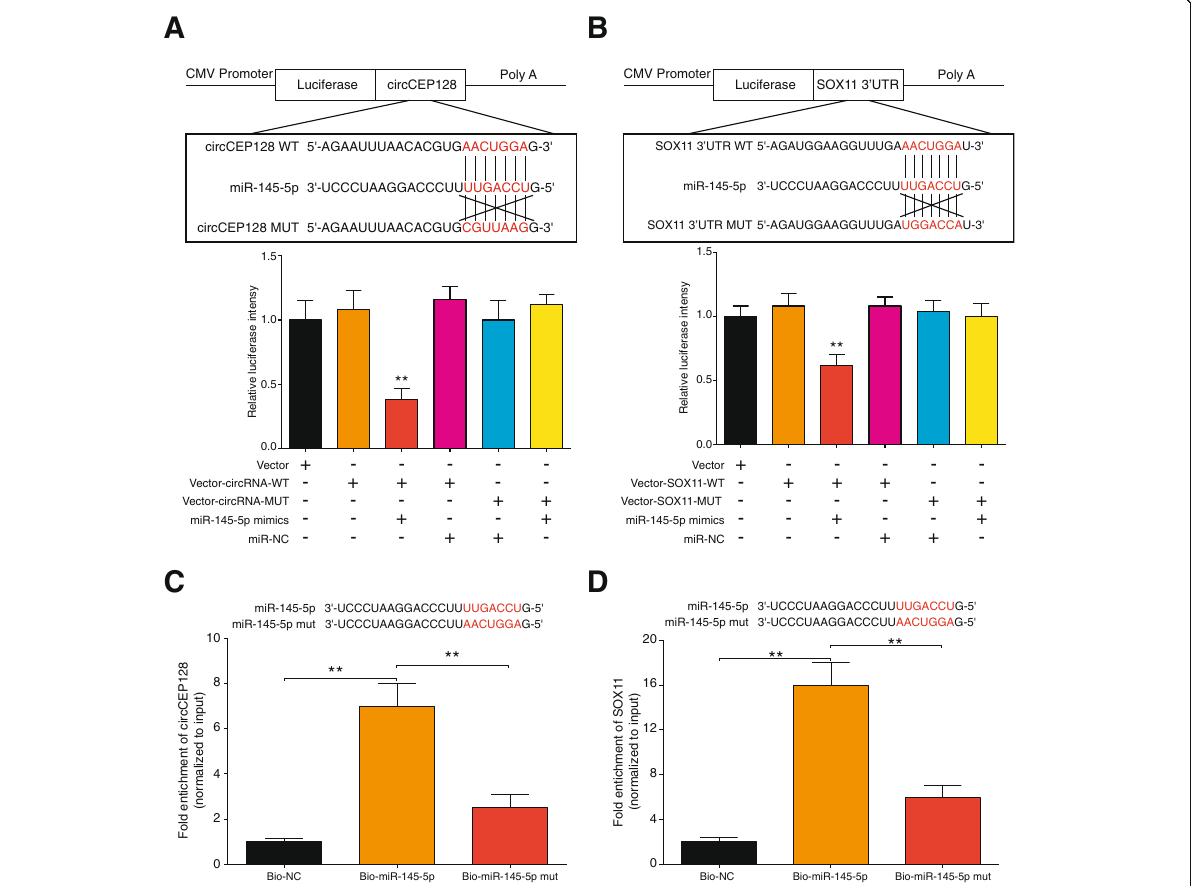
Fig. 3 CircCEP128 serves as a sponge of miR-145-5p and indirectly targets at SOX11 . a and b Binding sites of miR-145-5p in circCEP128/SOX11 3 ’ UTR (Up). Luciferase reporter assay revealed that miR-145-5p was able to reduce the luciferase intensity more than 40% by targeting at wild type RNAs (WT, Down). ** P < 0.01, compared with the group with only vector. c and d RNA pull-down assays indicated the physical interactions between circCEP128 and miR-145-5p or between miR-145-5p and